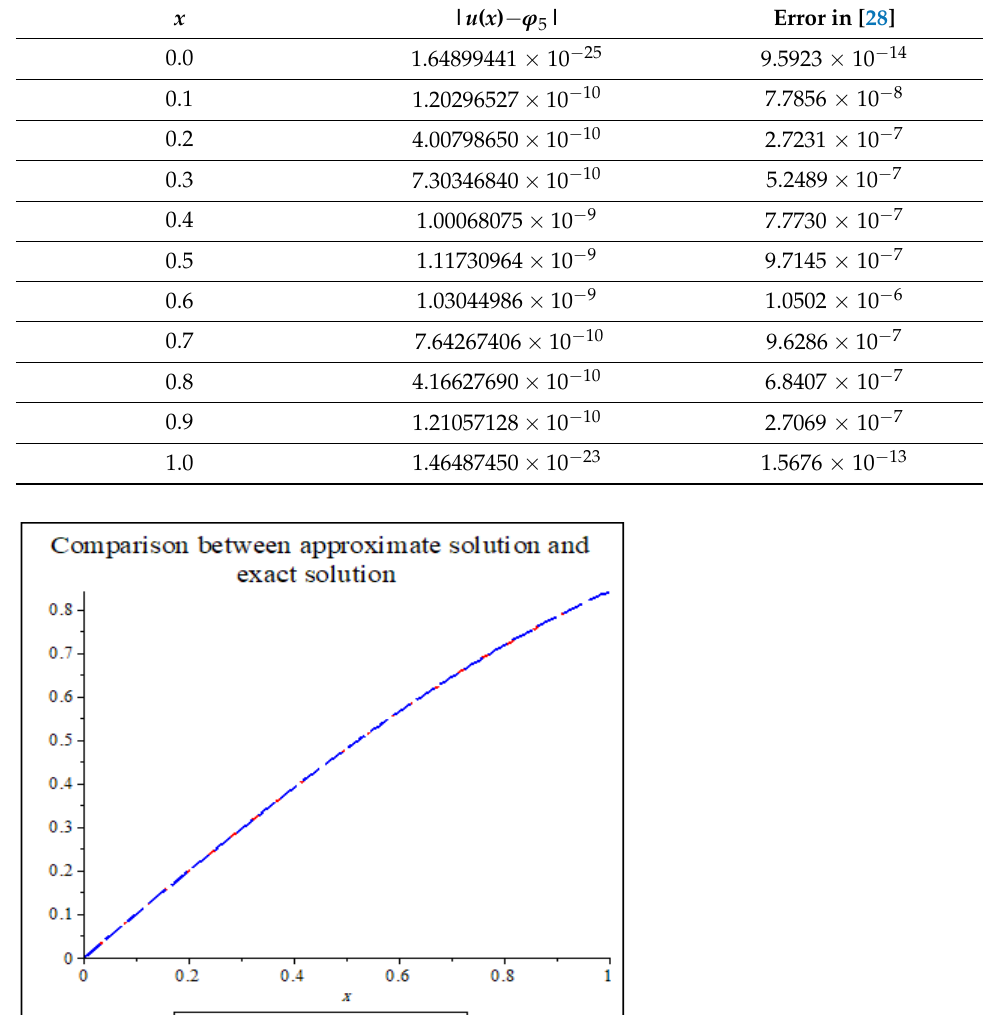
Table 2. The absolute error between the exact solution and ϕ 5 in Example 2.